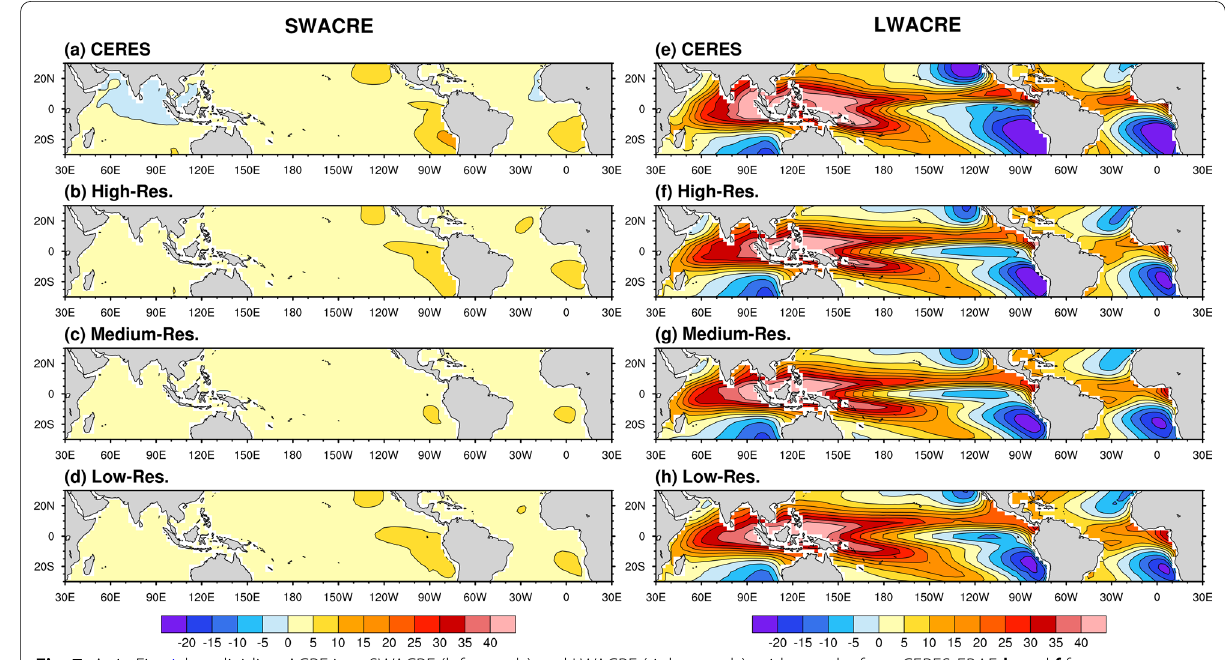
Fig. 7 As in Fig. 4, but dividing ACRE into SWACRE (left panels) and LWACRE (right panels), with a and e from CERES‑EBAF, b and f from high‑resolution, c and g from medium‑resolution, and d and h from low‑resolution groups of CMIP6 models. The color (or contour) interval is 5 wattm − 2